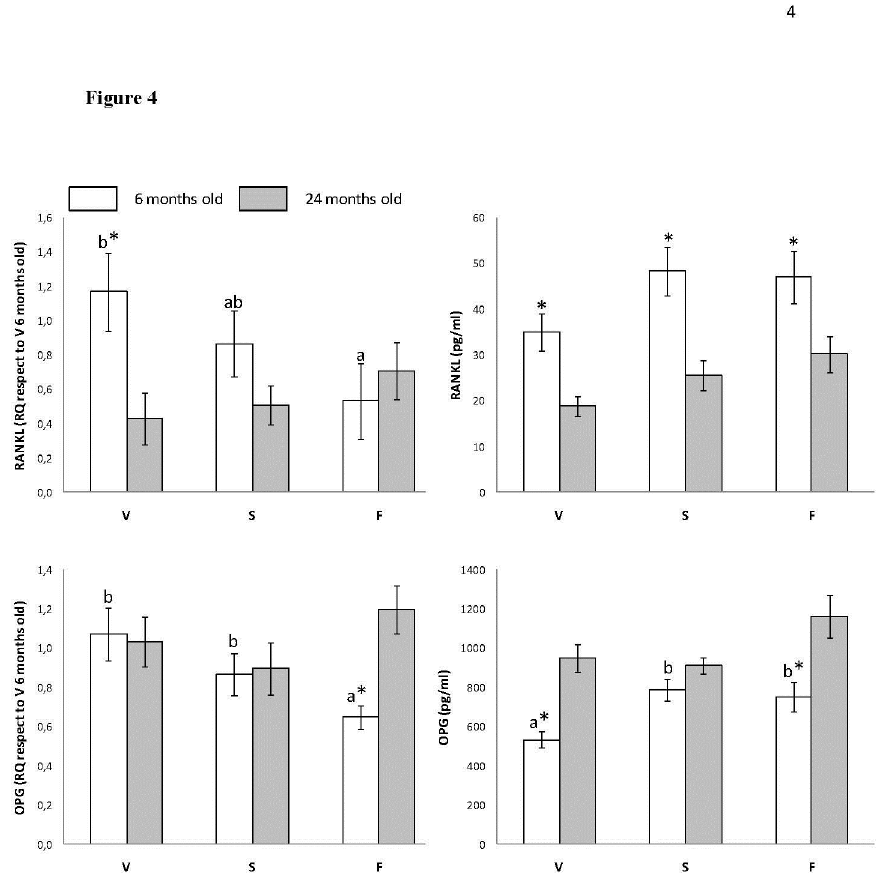
Figure 4. Effects of dietary fat type on gingival mRNA and circulating levels of bone resorption markers (RANKL and OPG) of young (6 months old) and old (24 months old) rats fed on virgin olive (V), sunflower (S) or fish (F) oils. Results are presented as mean ± EEM. Asterisk (*) means a statistically significant difference between the same dietary treatment for rats aged 6 and 24 months. Lower-case letters, when different, represent statistically significant differences ( P < 0.05) between the three dietary treatments at 6 months. Upper-case letters, when different, represent statistically significant differences ( P < 0.05) between the three dietary treatments at 24